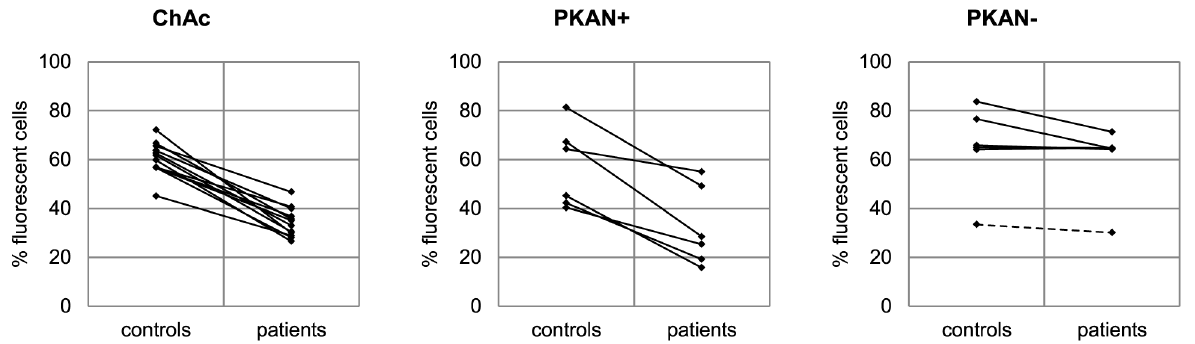
Figure 4. Impaired drug-induced endovesiculation in erythrocytes of patients with acanthocytosis. Erythrocytes from patients (ChAc, PKAN+, PKAN-) and control donors were subjected to drug-induced endovesiculation using 3 mM primaquine. The amount of FITC-dextran positive cells (in %) was assessed by flow cytometry as described. Respective pairs of patient and control donors are connected by lines. The data of the MPAN patient within the NBIA/PKAN- cohort is shown as a dashed line.